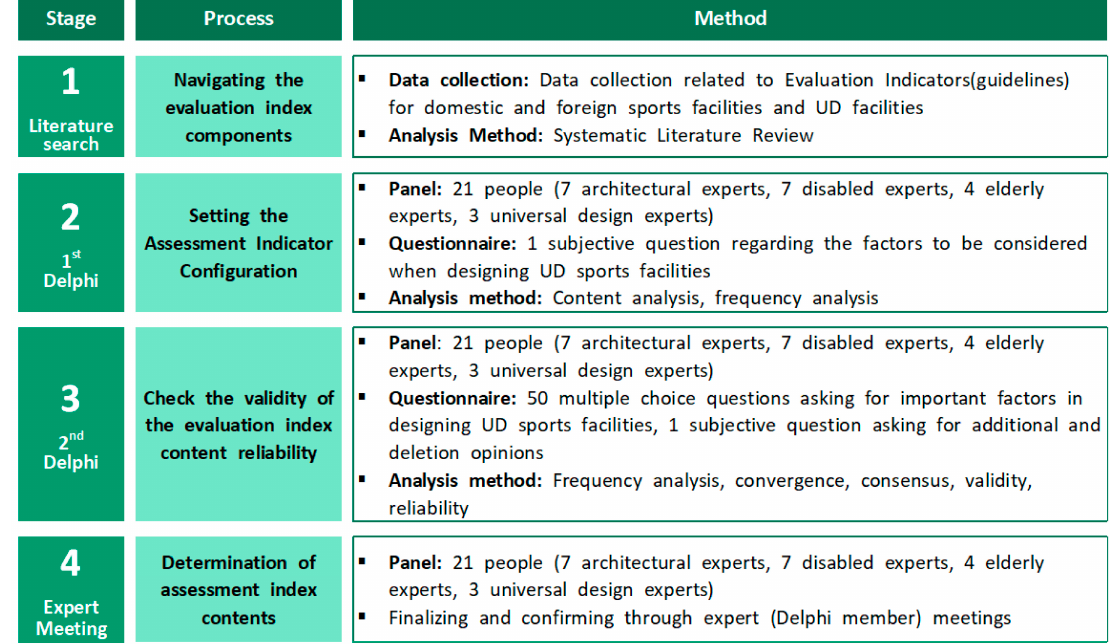
Figure 1. Research